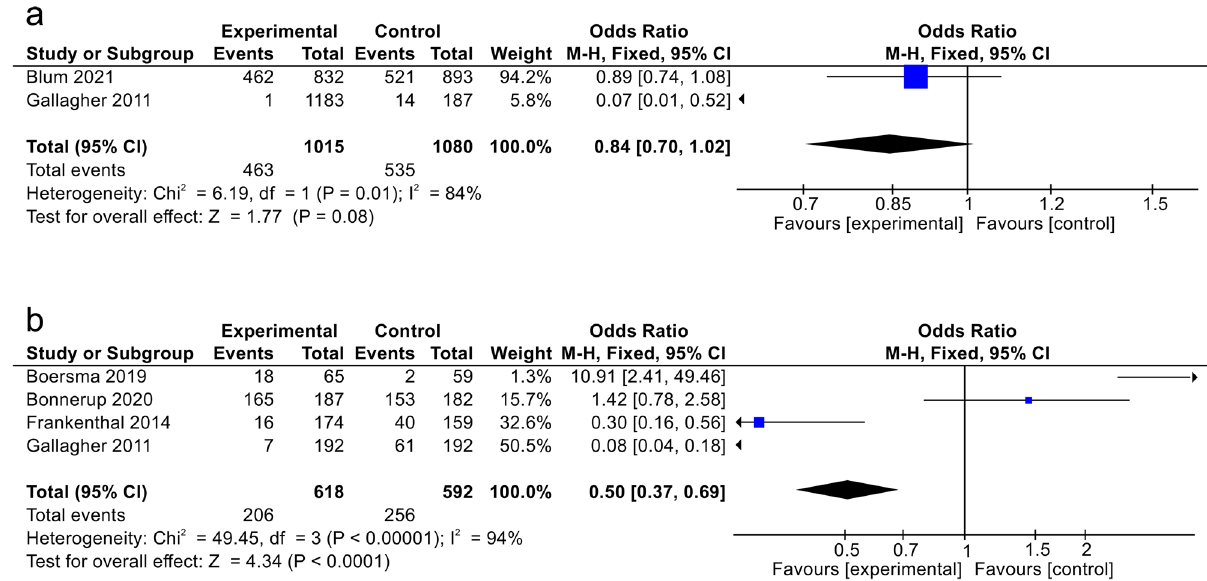
Figure 3. ( a ) “Meta-analysis” of the effect of interventions on A: number of reducing drug interactions within 2 months; ( b ) number of potential prescription omission